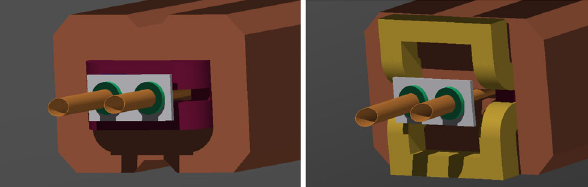
FIG. 5. Geometry model of the warm dipoles in LHC (left) and HE-LHC (right), highlighting the different coil design at the magnet extremity.